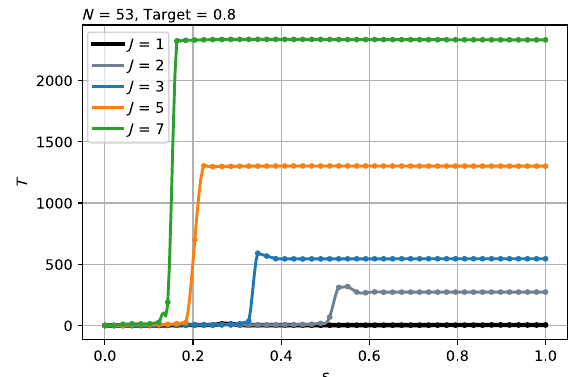
FIG. 9. Adiabatic spectroscopy for N = 53 qubits and a given target ground-state fidelity of 0.8. We perform adiabatic sweeps from 0 to s and find the evolution time T required to reach the tar- get fidelity. We obtain data for 50 values of s , linearly distributed along the x axis. When a phase transition needs to be overcome, T increases to a much larger value. The steepness of the curve at this point provides a measure for the smallness of the spectral gap.